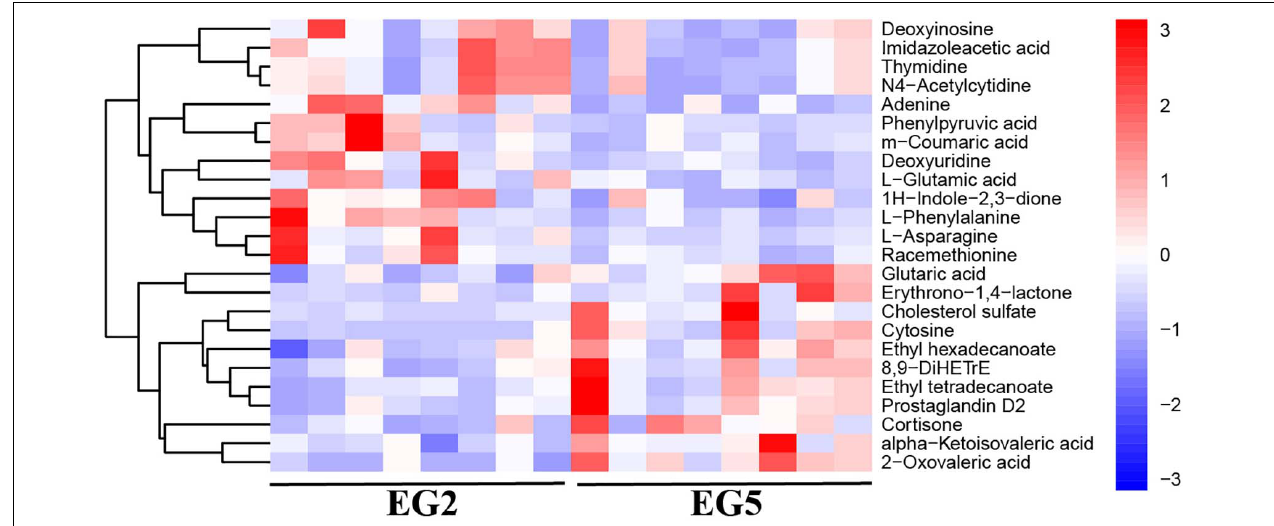
FIGURE 4 | Hierarchical clustering analysis on SDMs from NEG. The relative metabolite level is depicted according to the color scale. Red and blue indicate upregulation and downregulation, respectively.